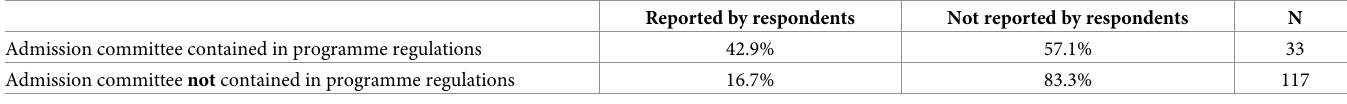
Table 3. Admission via ‘Admission Committee interview’ as stated in doctoral programmes regulations and the reported practices by their